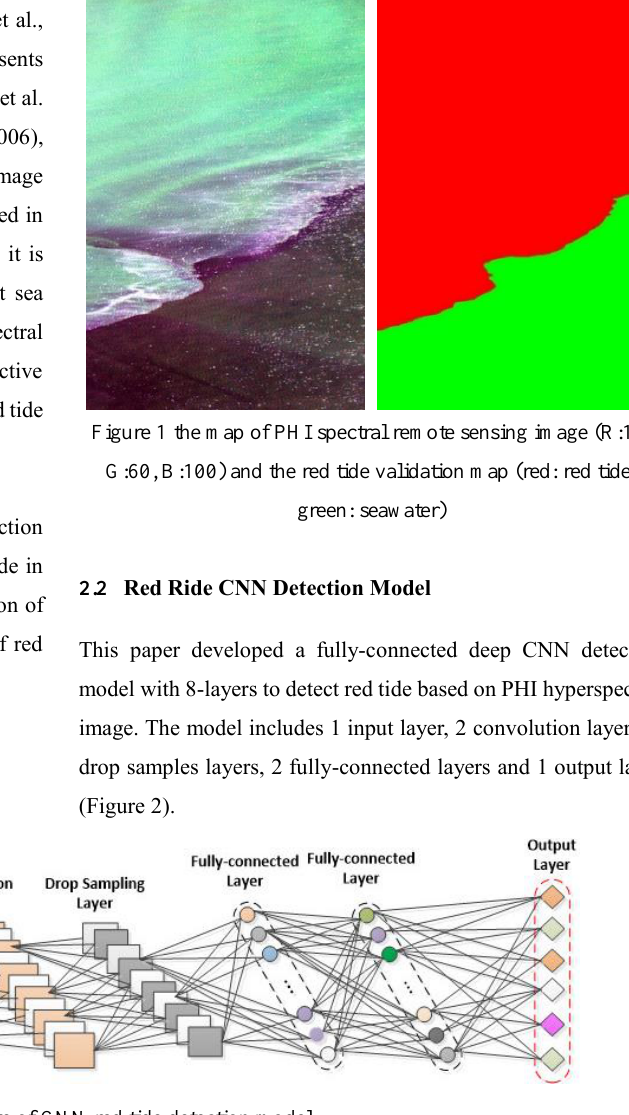
Figure 2 The structure of CNN red tide detection